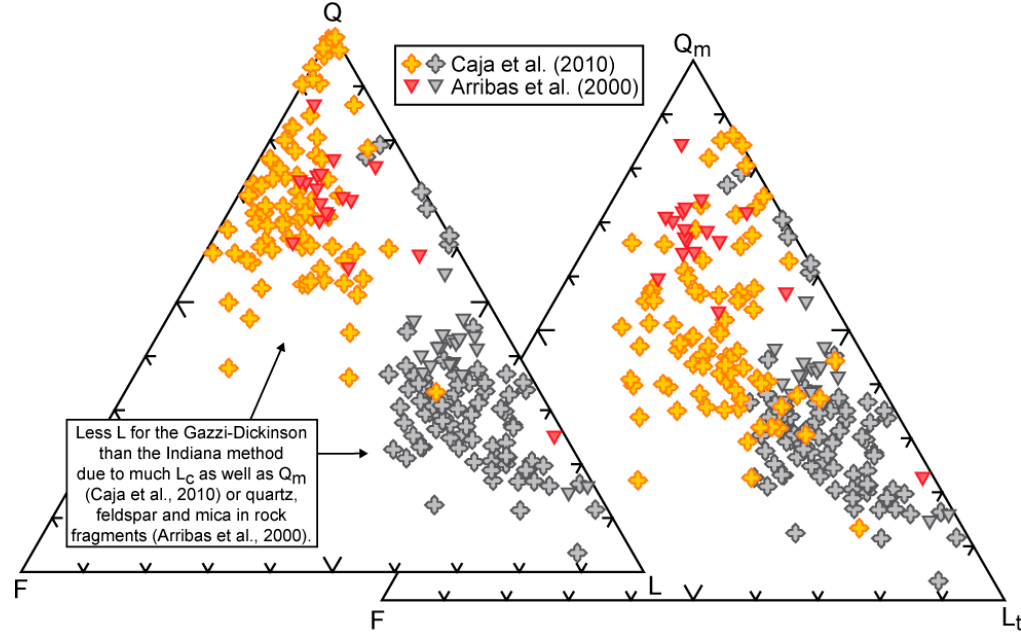
Figure 4. Apparent quartz-feldspar-lithic-fragment/rock-fragment (Q-F-L) composition difference for point-counting re- sults based on the Gazzi–Dickinson (coloured symbols) and “pseudo”-Indiana (grey symbols) methods. Q includes mono- crystalline and polycrystalline quartz with chert for Gazzi–Dickinson-counted data, but only monocrystalline quartz for Indiana-method data. L only includes poly-mineralic grains for Gazzi–Dickinson data, but also carbonate and polycrys- talline quartz (including chert) for Indiana-method data. For comparative reasons, the data also are shown with only monocrystalline quartz in the Q pool (Q m ) and all polycrystalline quartz in the L pool (L t ) (cf. [1]). The data for the “pseudo”-Indiana method is the same in both diagrams, as only monocrystalline quartz grains count as quartz. Clasts that were unspecified in the publications are included in the lithic-fragment pool (mostly 0–2% of the framework volume). The story is partly different for recent fluvial sand from the Henares River in central Spain [47] that includes on average 11% carbonate clasts in the framework (equivalent to 40% of the total rock fragments). The amount of sand-sized quartz, feldspar, and mica crystals in rock fragments is 20%. The quartz fraction contains on average only 3% poly- crystalline grains. The catchment area is mostly composed of metamorphic rocks, partic- ularly in the upper part of the river system; carbonate rocks occur only to a minor degree in the catchment [47]. Thus, also in this study, the carbonate clasts are overrepresented. Both the high carbonate content and the high amount of sand-sized quartz, feldspar, and mica in rock fragments in the Henares River study [47] cause a quartz-richer apparent composition for Gazzi–Dickinson-method than Indiana-method results (Figure 4). The low amount of polycrystalline quartz leads to a minor difference when only monocrystal- line quartz (of Gazzi–Dickinson-method-based data) is part of the quartz pool (Figure 4). If a large amount of quartz, feldspar, and mica in rock fragments are treated as proper rock fragments in Gazzi–Dickinson-based discrimination schemes (because of the use of a different counting method), an arc-related depositional environment can falsely be as- sumed (Figures 1 and 4). The two cases not only illustrate that apparent compositional differences based on the definition of the lithic/rock-fragment pool may be unrelated to geological processes